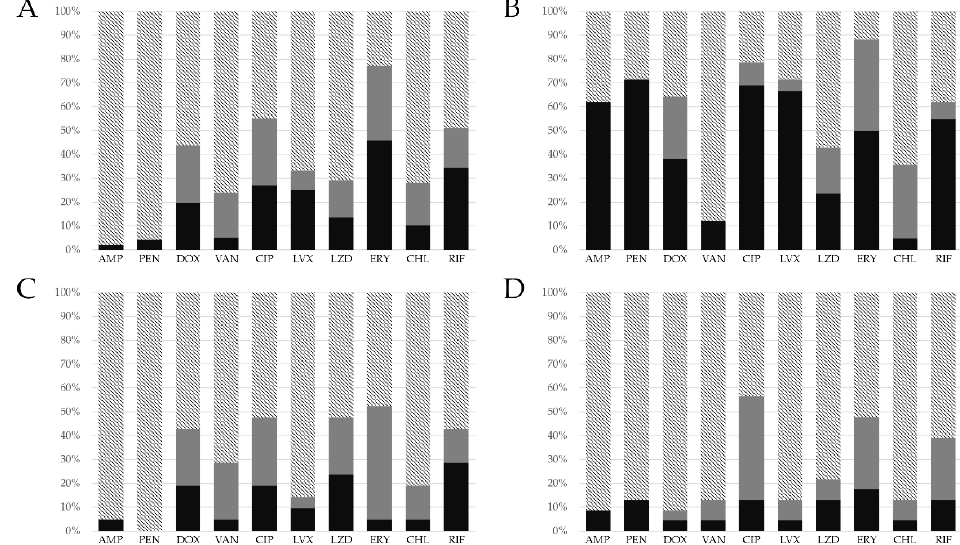
Figure 2. Antibiotic resistance profiles of Enterococcus strains isolated from dogs with otitis externa. ( A ) E. faecalis . ( B ) E. faecium . ( C ) E. hirae . ( D ) E. casseliflavus . AMP, ampicillin; PEN, penicillin; DOX, doxycycline; VAN, vancomycin; CIP, ciprofloxacin; LVX, levofloxacin; LZD, linezolid; ERY, erythromycin; CHL, chloramphenicol; and RIF, rifampin. Striped, susceptible; gray, intermediate; and black, resistant.